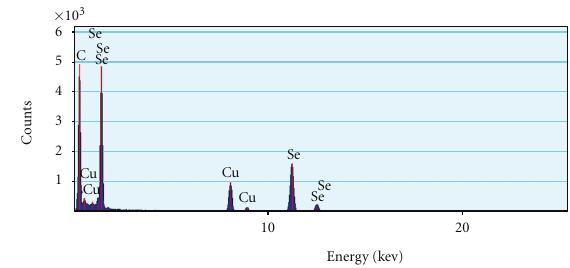
Figure 4: EDAX pattern of the selenium nanoparticles, synthesized by the reaction of 1 . 0 × 10 − 3 moldm − 3 sodium selenosulphate with 2 . 0 × 10 − 2 moldm − 3 acetic acid, in the presence of 0.01%